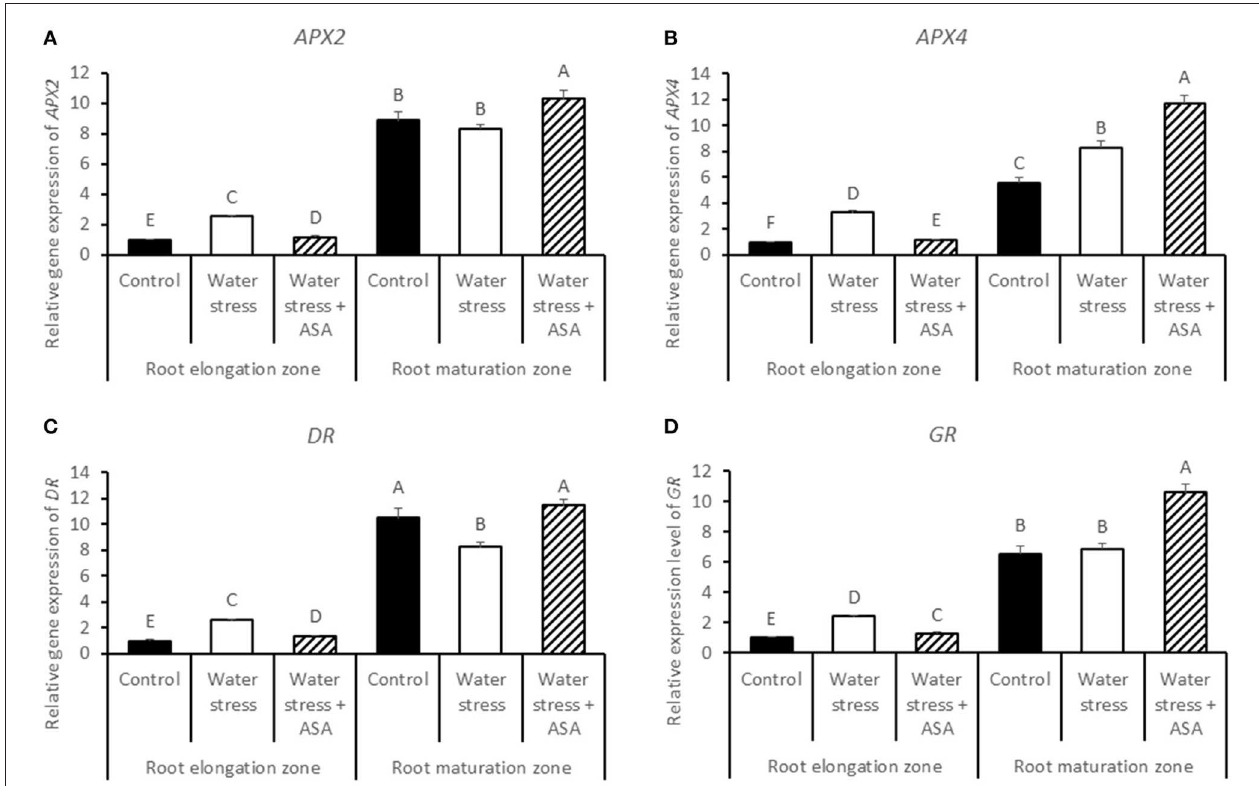
FIGURE 10 | Relative gene expression level of APX2 (A), APX4 (B), DR (C), and GR (D) in tall fescue roots exposed to non-stress control, water stress, and water stress with ASA treatment. The data represent mean ± SE ( n = 4 replicated pots of plants and each pot with multiple plants). Columns marked with the same letter are not significantly different at p < 0.05